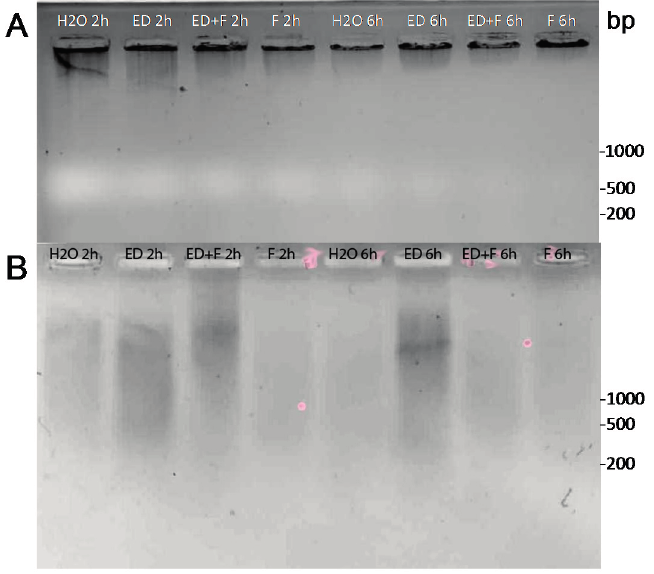
Figure 4. EDTA applications to pea endocarp tissue result in fragmentation of DNA in the period disease resistance is initiated (1–6 h). DNA was extracted from pea endocarp tissue ( A ) treated for 2 h and 6 h with (10 μ L) water (H 2 O), 6 mM EDTA (ED), 6 mM EDTA + Fusarium solani f. sp. phaseoli spores (ED + F) or F. solani spores only (F). DNA (2 µg